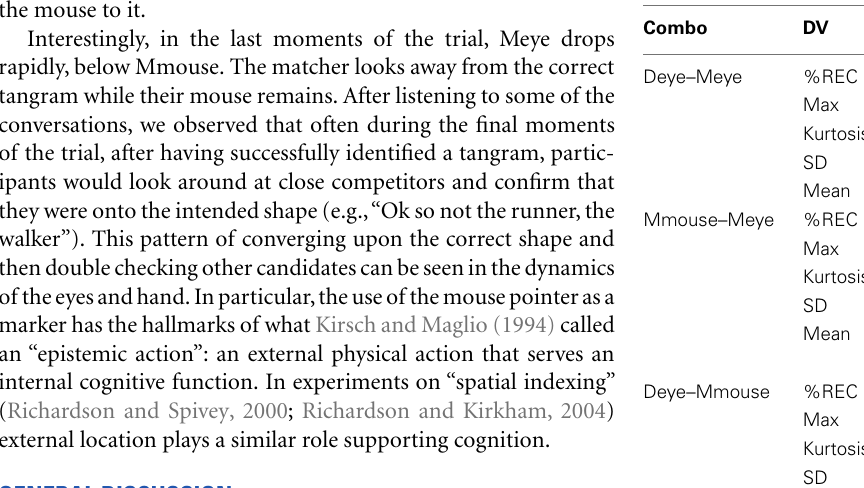
Table 1 | Summary of basic findings of distribution measures across